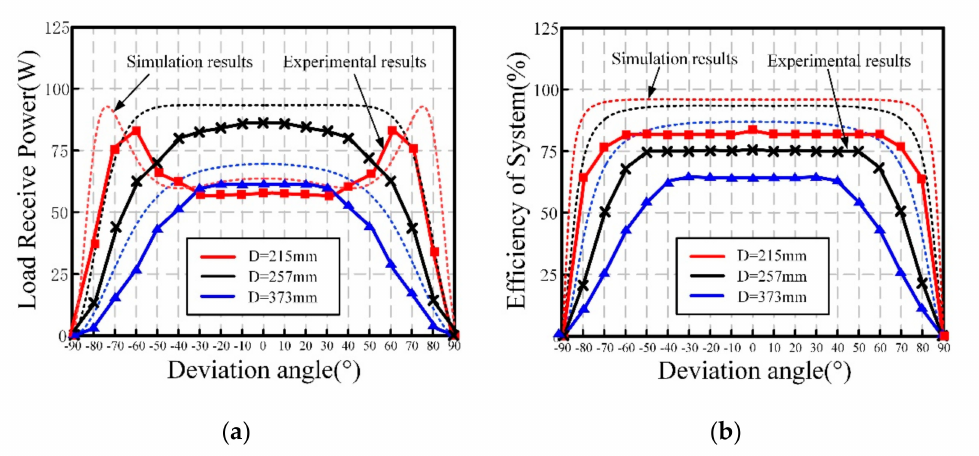
Figure 14. Experimental results at di ff erent distances. ( a ) Load receive power vs. deviation angle. ( b ) System e ffi ciency vs. deviation